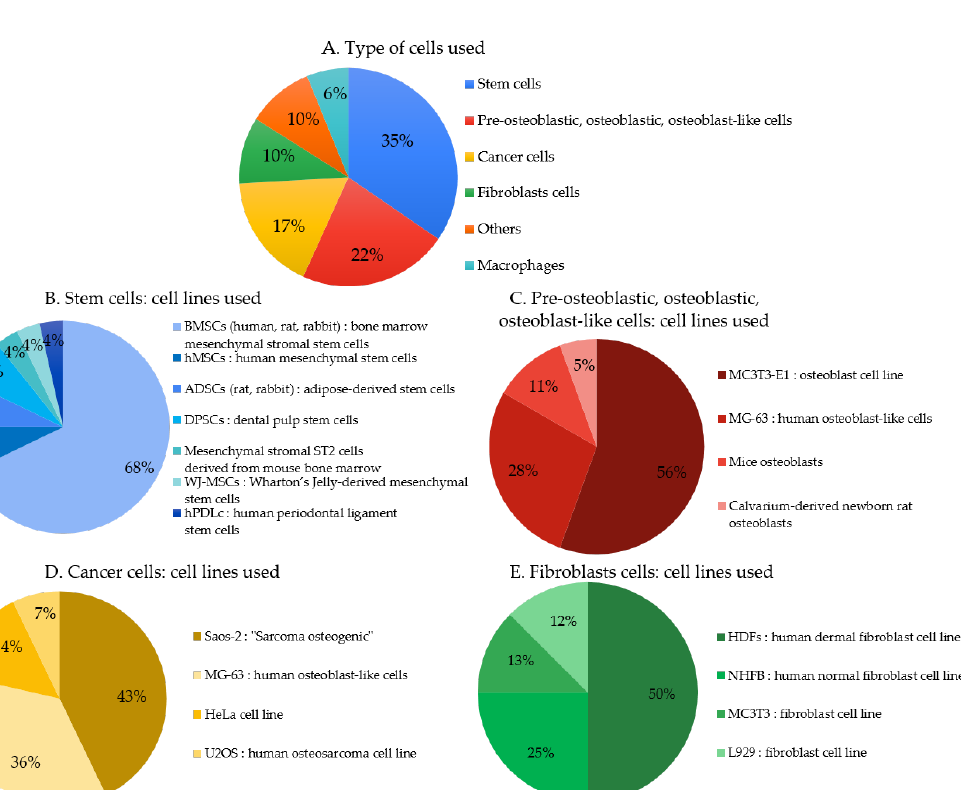
Figure 5. Doping and adjuvants of MBGs used in studied articles.